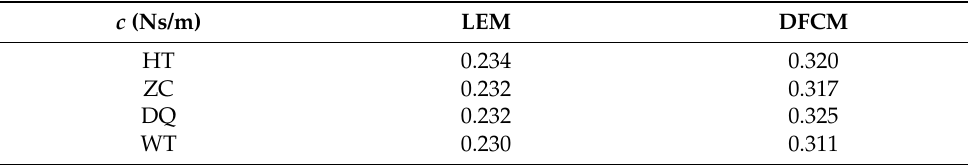
Table 4. Estimated damping coefficient of the experimental